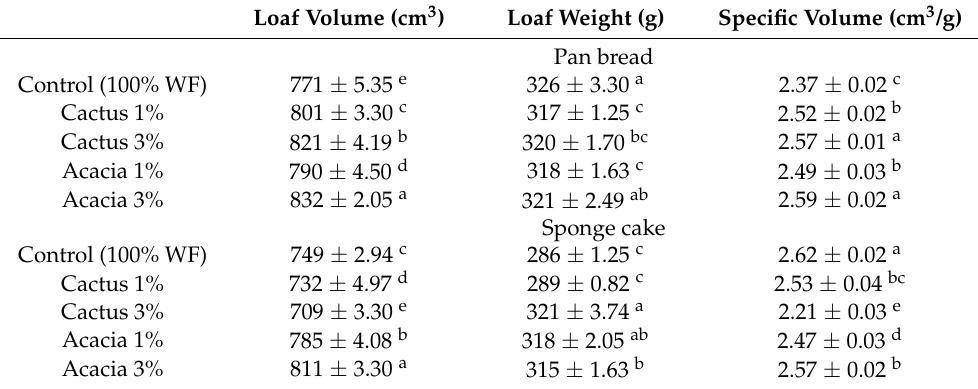
Table 5. Effect of acacia and cactus gums on the volume, weight, and specific volume of bread and cake